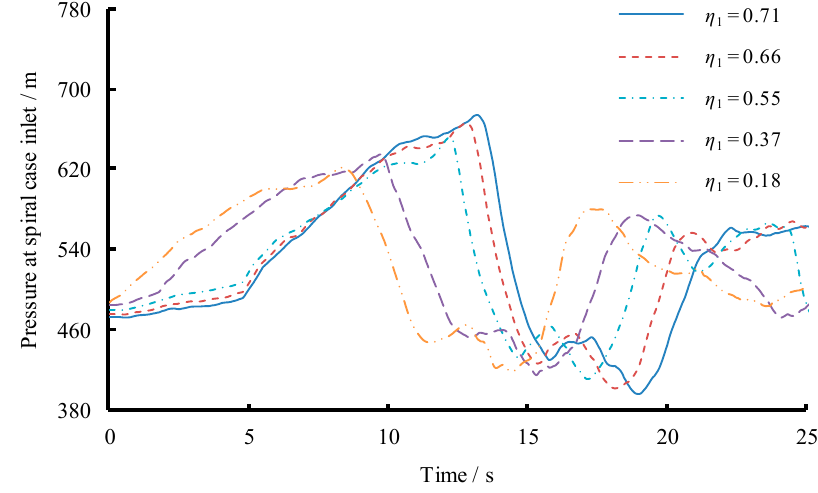
Figure 8. Spiral case pressure of different η 1 versus time for Scenario 1.